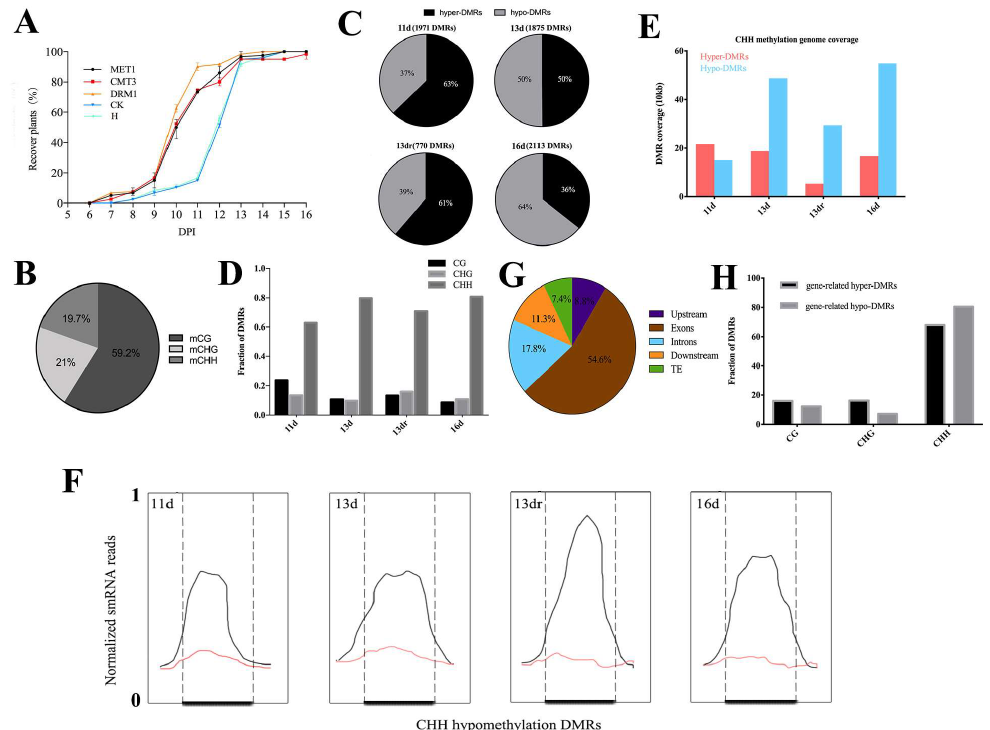
Figure 1. Viral infection is associated with DNA methylation and demethylation. ( A ) Developmental stages of tobacco leaves from 11 d to 16 d and their comparison with healthy leaf. Green parts of leaf at 13 d stage are marked as 13 dr. Red dots are selected tissues for DNA extraction and library construction; ( B ) Context breakdown for mCs. Values are the mean percentages of mCs in all libraries; ( C ) Total number of differentially methylated regions (DMRs) and distribution of hyper- and hypo-DMRs; ( D ) Context enrichment of DMRs; ( E ) Genome coverage of identified CHH hyper- and hypo-DMRs; ( F ) Average distribution of 24-nt siRNA reads in healthy tissues (black) and infected tissues at different stages (red) over defined CHH hypomethylation DMRs in indicated samples. The X-axis indicates CHH hypomethylated DMRs (dark lines in the middle) and their flanking regions. Flanking regions are the same length as middle regions. siRNA reads were normalized based on their frequency; ( G ) Percentages of DMRs mapping to different genomic categories; ( H ) Context enrichment of gene-related